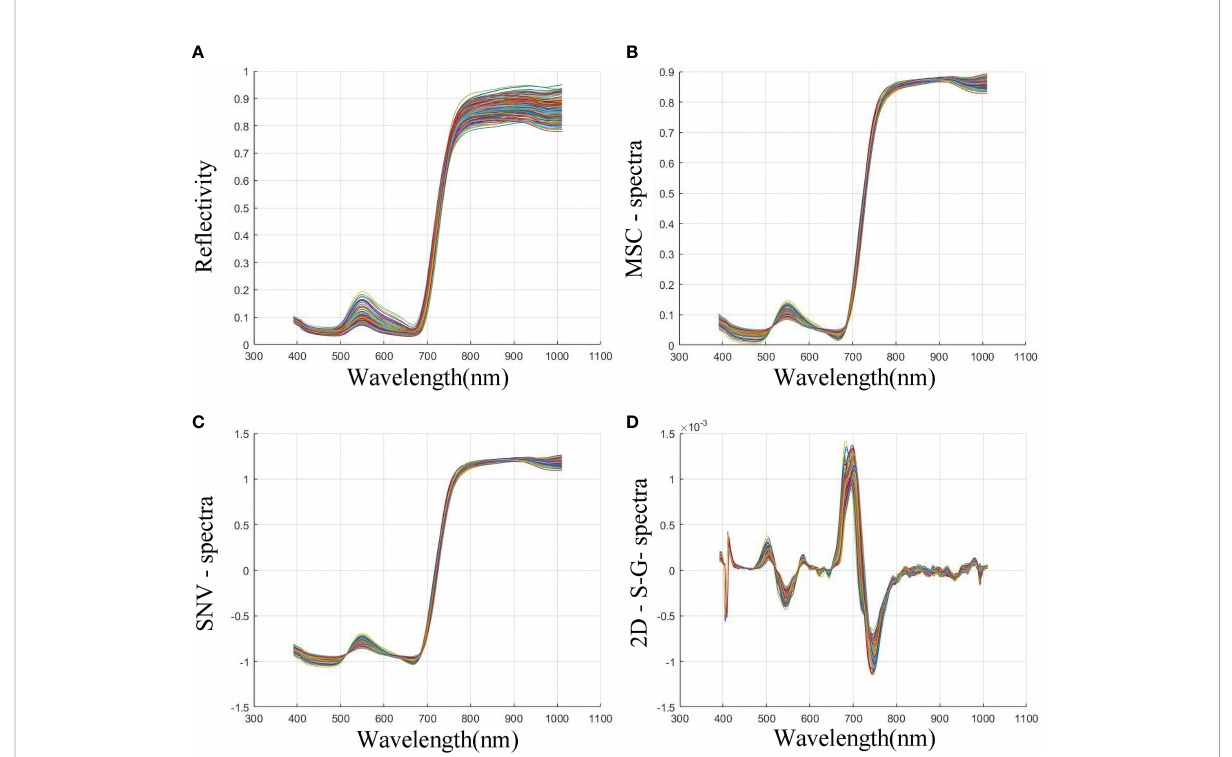
FIGURE 7 Changes of spectral data under different pretreatment methods. (A) Original bands image; (B) Bands image after MSC processing; (C) Bands image after SNV processing; (D) Bands image after second-order differential and S-G method